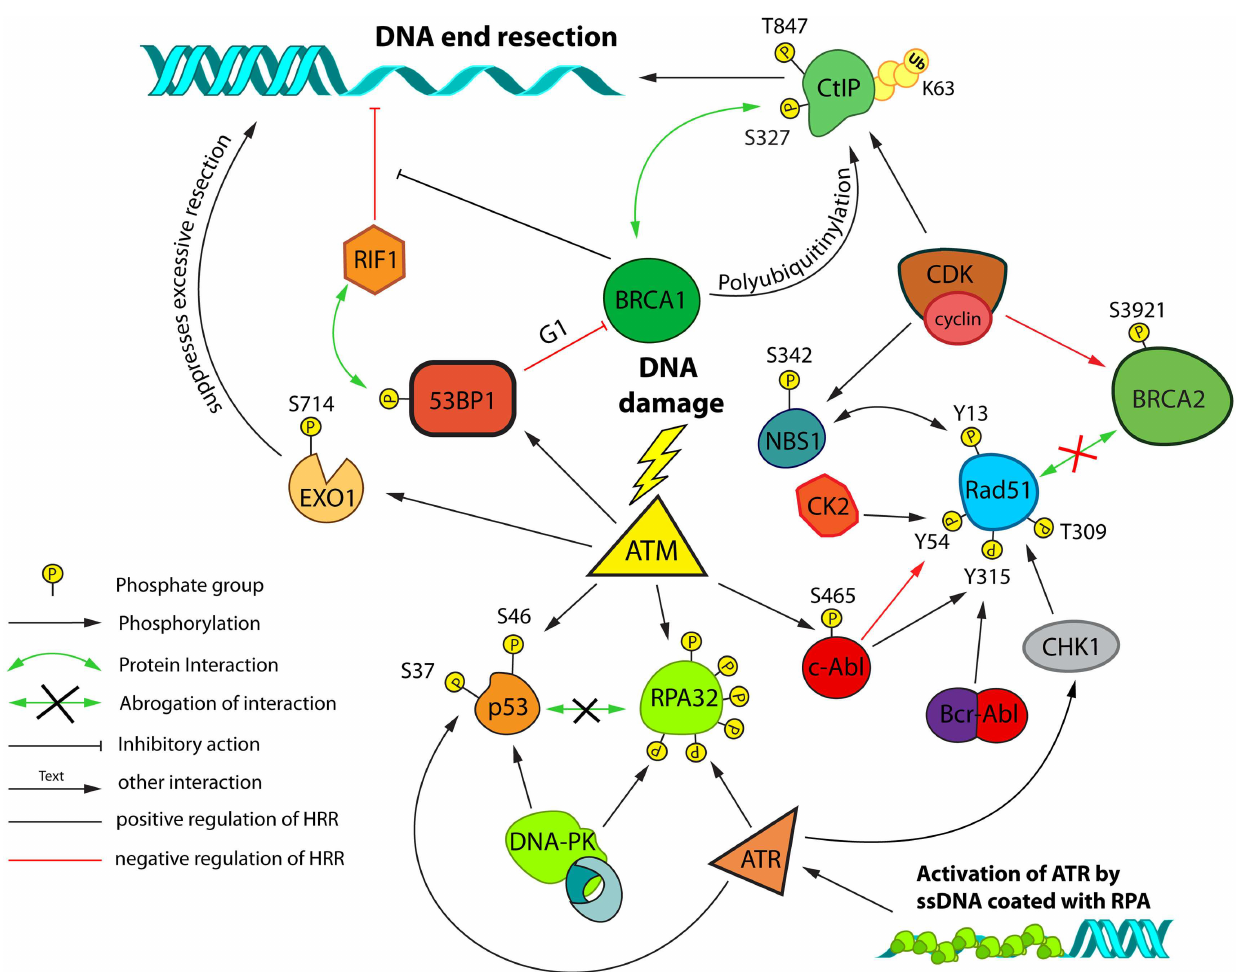
DNA damage primarily relies on the activities of ATM, ATR, and DNA-PKcs. Control of end-resection plays a central role in this regulation. Resected DNA decorated with heterotrimeric RPA complexes forms a platform for activation of ATR.The schematic focuses on interactions/modifications implicated in the regulation of